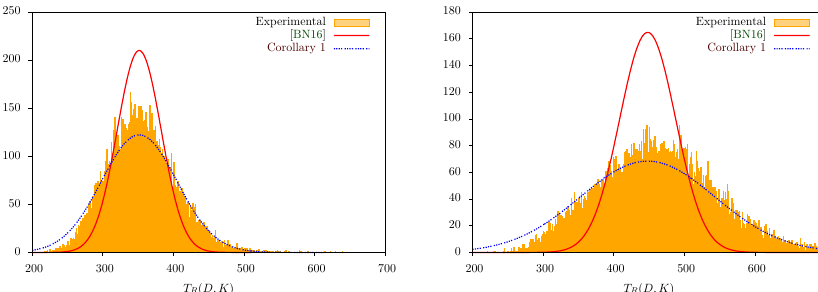
Figure 4: Comparison between the experimental distribution of T ( D, K ) and normal distributions with mean B‘ + NC and different variances recalled in this paper. Left with N = 2 14 . Right with N = 2 15 . Experiments in the DKP